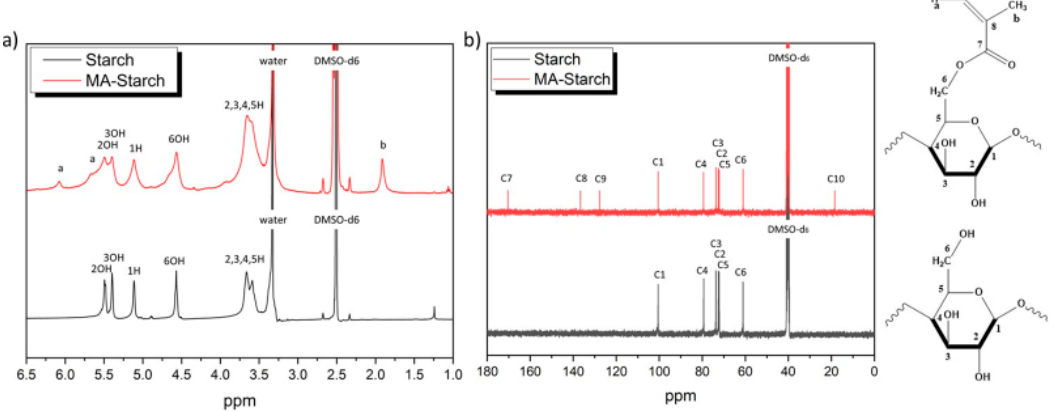
Figure 1. ( a ) 1 H-NMR spectra; and ( b ) 13 C-NMR spectra for Starch-reference before methacrylation and methacrylated MA-Starch with peak assignments.